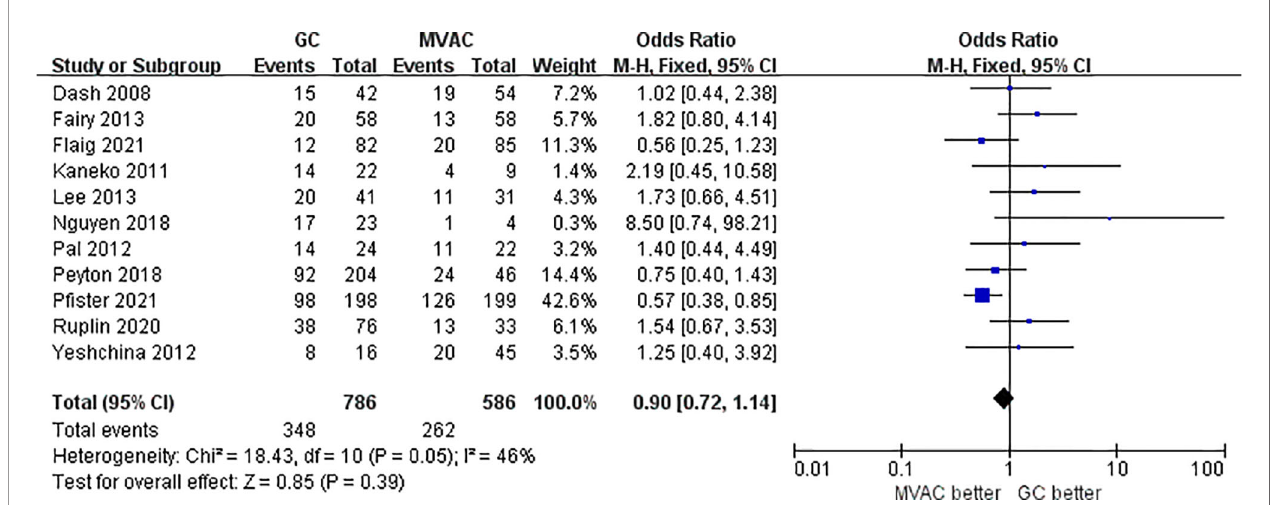
FIGURE 5 | Forest plot of pathological partial response (PPR) to GC versus MVAC.